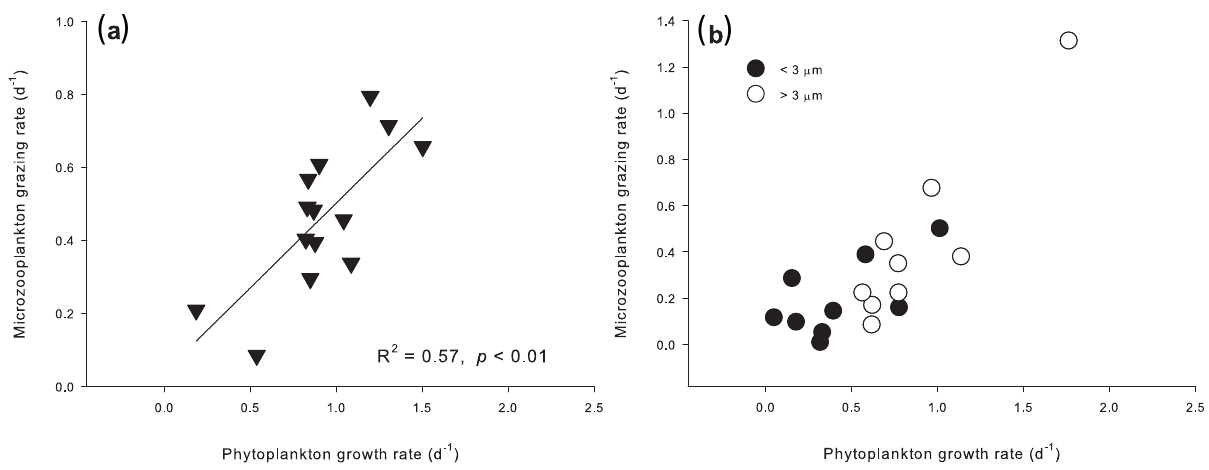
Figure 5. Correlationship between phytoplankton growth and microzooplankton grazing rates. (a) May to June 2009; (b) November 2010; > 3µm, size fraction larger than 3µm; < 3µm, size fraction smaller than 3µm. Table 5. Comparisons of environmental variables, and phytoplankton growth and microzooplankton grazing between May–June 2009 and November 2010 in the southern South China Sea. SST, surface seawater temperature ( ◦ C); SSS, surface seawater salinity; Si, silicate (µmolL − 1 ); Chl a , chlorophyll a (µgL − 1 ); µ n , phytoplankton growth rates with nutrient amendment (d − 1 );µ, phytoplankton growth rates without nutrient amendment (d − 1 ); m , microzooplankton grazing rates (d − 1 ); p , the significant level. The mean ratio values of µ/µ n and m/µ were compared based on the Mann-Whitney test, while the other mean values were compared based on the independent t test. The ratio values of µ/µ n and m/µ were shown as geometric mean ± standard deviation, while other parameters were displayed as arithmetic mean ± standard